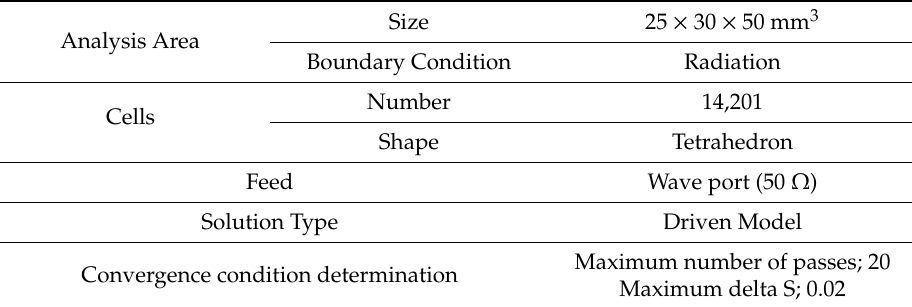
Table 1. ANSYS High Frequency Structure Simulator (HFSS) Simulation